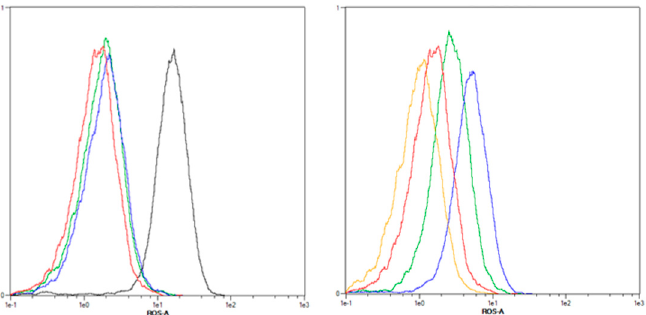
Figure A1. Representative flow cytometric analysis of ROS formation in SISO cells. Cells were treated with solvent (red and yellow), H 2 O 2 (black), and the IC 50 (green) or IC 90 (blue) of mTHPC. Afterwards, cells were kept in the dark (left) or were illuminated with 1.8 J / cm 2 (right) and stained with H 2 DCF-DA directly after illumination. For each sample, 10,000 events were counted and gated for the single cell population (not shown). DCF fluorescence was detected with the FITC channel ( λ Ex / Em = 488 / 525–550 nm) of a MACS Quant flow cytometer. Data were analyzed with the MACS Quantify Software.